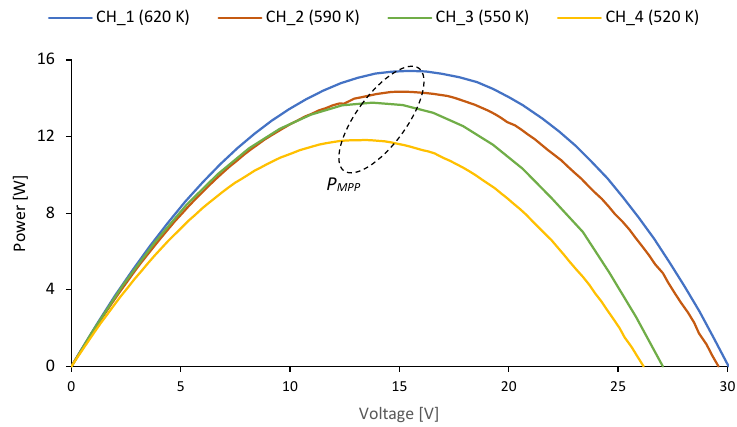
Figure 11. I – V and P – V characteristics of the tested thermoelectric generator.